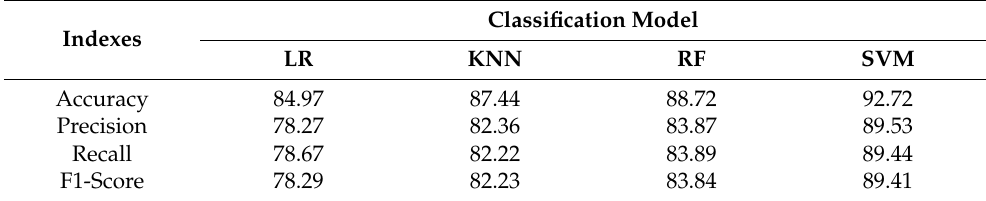
Table 4. The overall average recognition ability comparisons of different classification models